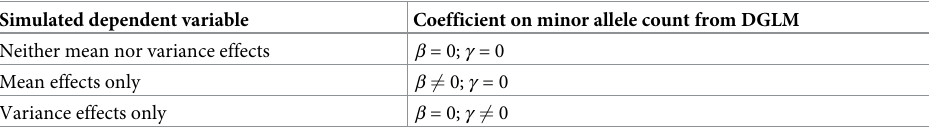
Table 1. Outcomes versus